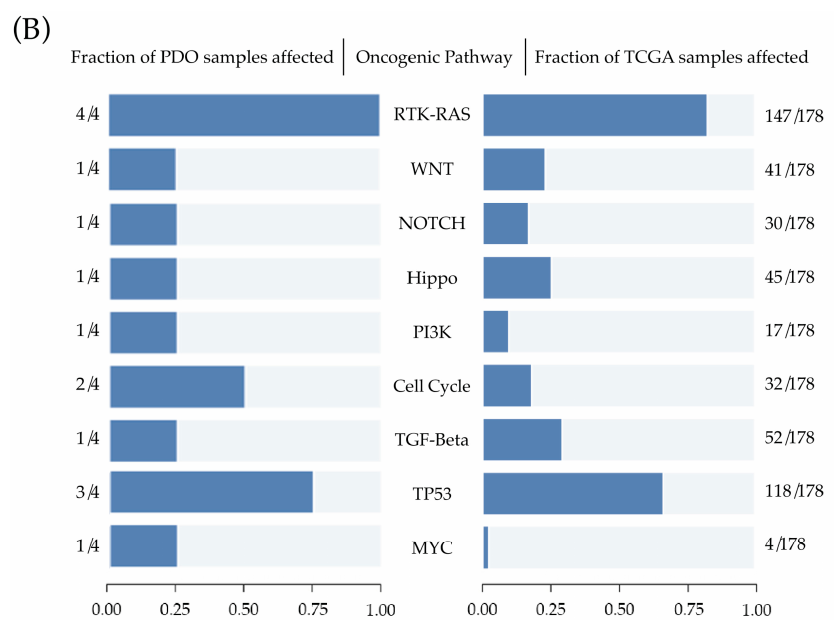
Figure 2. Whole exome sequencing of PDOs ( A ) Oncoplots depicting the 15 most commonly altered genes in The Cancer Genome Atlas (TCGA) cohort of Pancreatic Adenocarcinoma ( left ) compared to the pathogenic and likely pathogenic alterations found by whole exome sequencing in PDAC PDOs, modelling the mutational patterns of their tissue of origin ( right ) ( B ) Visualization of pathway enrichment analysis showing the fraction of affected oncogenic signaling pathways in PDAC PDOs ( left ) compared to the fraction of affected oncogenic signaling pathways in TCGA cohort of Pancreatic Adenocarcinoma ( right